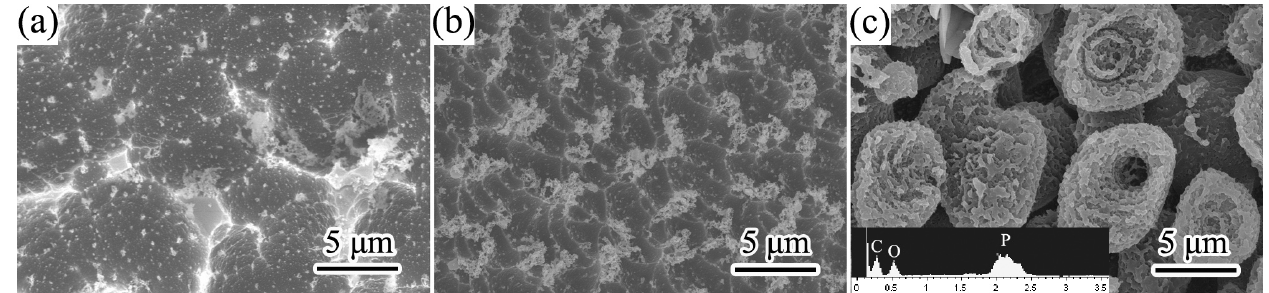
Figure 9. SEM images of based materials after AO erosion: ( a ) 6421resin, ( b ) PEK-C, ( c ) PS-100.